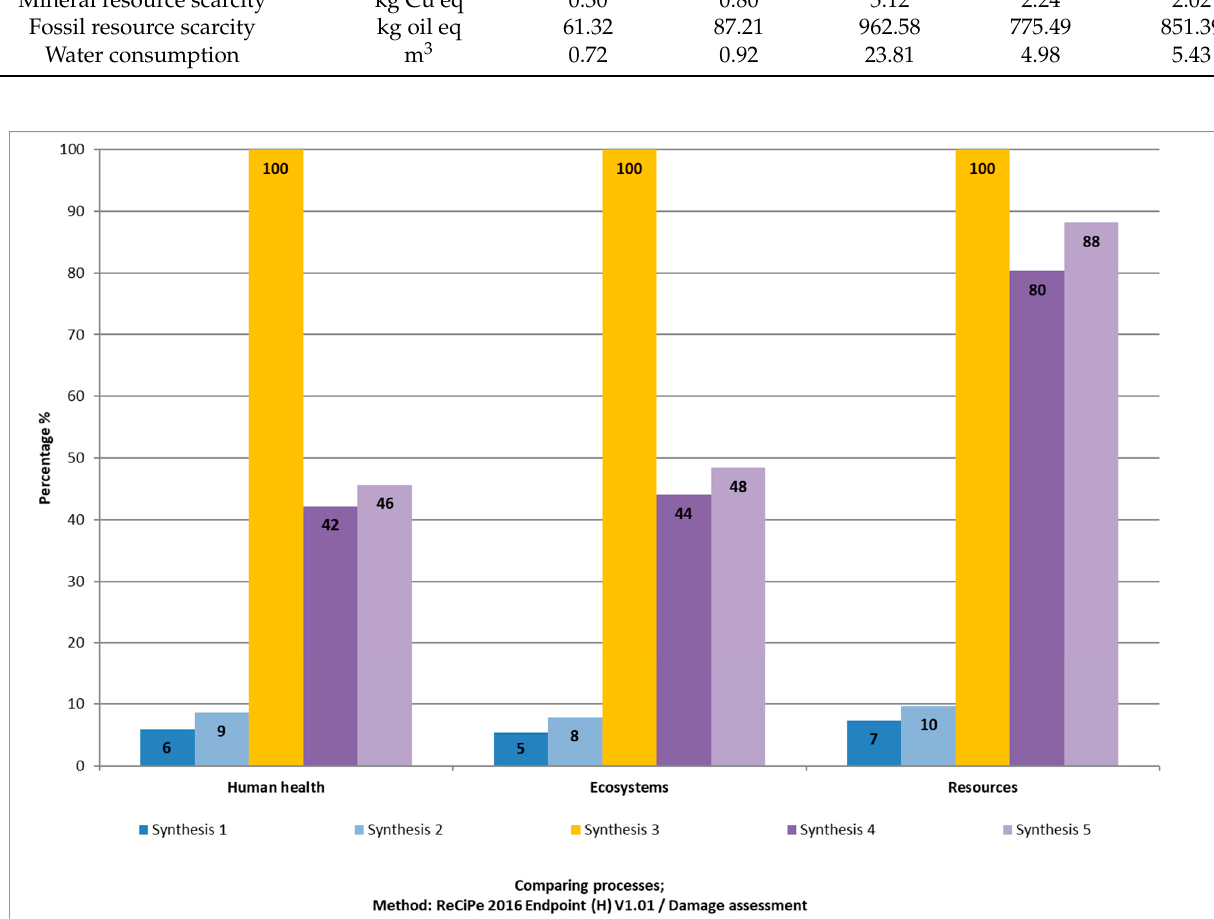
Figure 2. Comparative damage assessment of the five synthetic routes of ZIF-8.